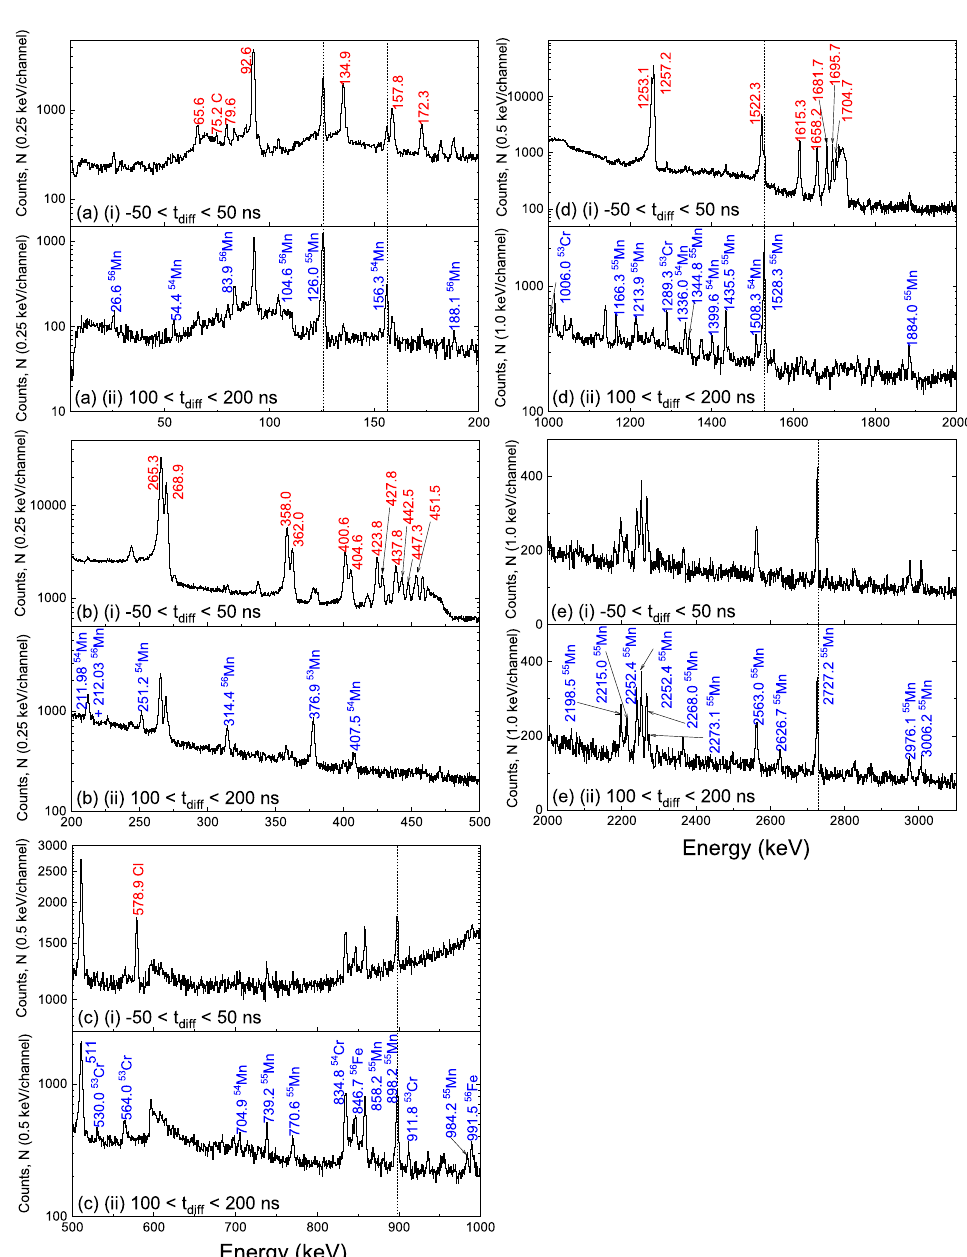
Figure 4. The prompt counts (N) of the muonic X-ray spectrum ((i) − 50 < t diff < 50 ns) and delayed counts (N) of the gamma-ray spectrum from the nuclear capture of muons ((ii) 100 < t diff < 200 ns) in the Fe layer of the three-layered sandwich sample at p = 28.6 MeV/c within the energy ranges of ( a ) 0 < E < 200 keV, ( b ) 200 < E < 500 keV, ( c ) 500 < E < 1000 keV, ( d ) 1000 < E < 2000 keV, and ( e ) 2000 < E < 3100 keV. The µ -X ray energies are written in red, while the gamma-ray energies are √ N ) is not shown for visibility of the smaller in blue. A statistical error of the data points (